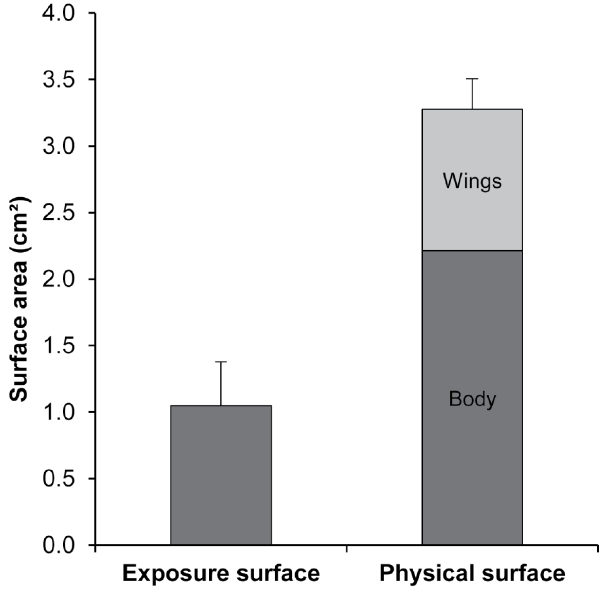
Figure 4. Comparison of the exposure and physical surface area of a bee. Mean exposure surface area ( 6 S.D.) of a bee (average of the 20 commercial products) and mean physical surface area ( 6 S.D.) of a bee (sum of the mean body and wing surface